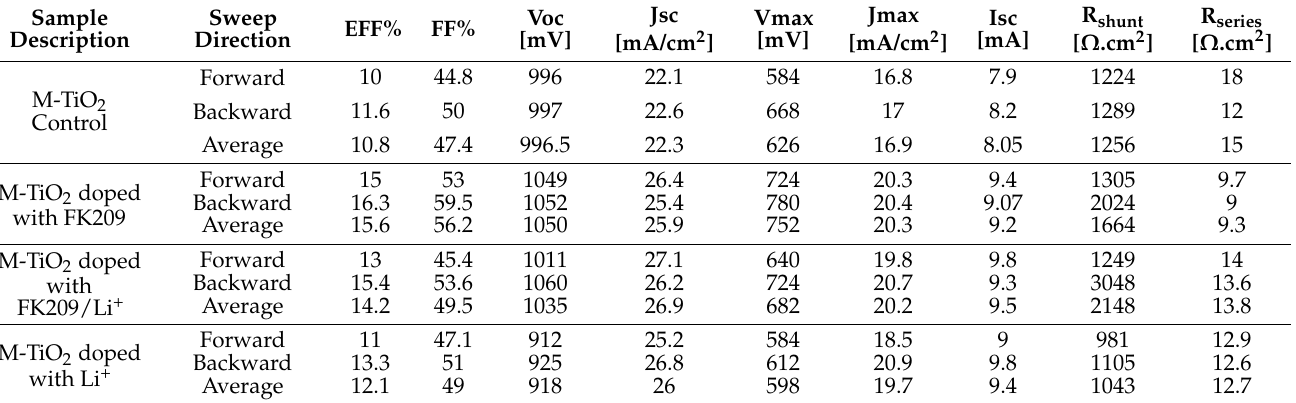
Table 2. Perovskite solar cell key parameters measured for the different dopants investigated in this study. It is showing the average value for each set of parameter.